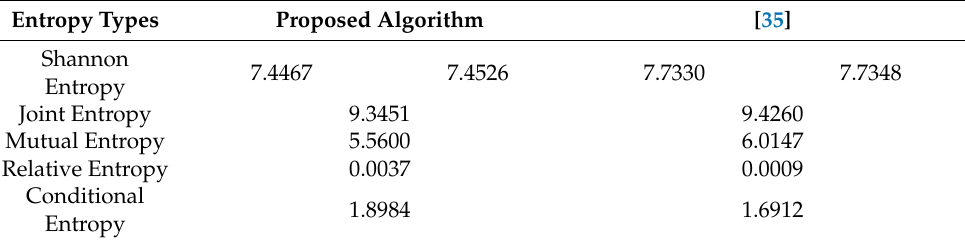
Table 5. Comparison of entropy types between the proposed algorithm and [35] for embedding 17,000 Bytes.